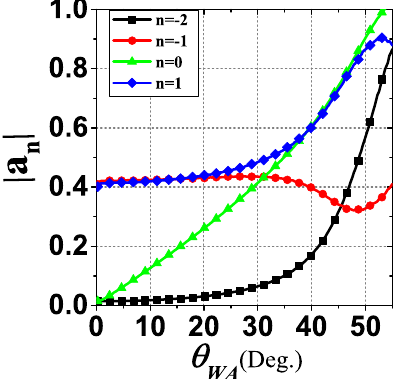
Fig. 3 Contribution from different multipole modes. Scattering coef fi cients of a QD for the four dominant angular-momentum channels as a function of θ WA . The contribution from other angular momentum channels is negligible. The channels n = − 2, n = − 1 ( n = 1) and n = 0 correspond to circular quadrupole, circular dipole, and isotropic modes, respectively. The QD is located in a linear array and inter-QD coupling is